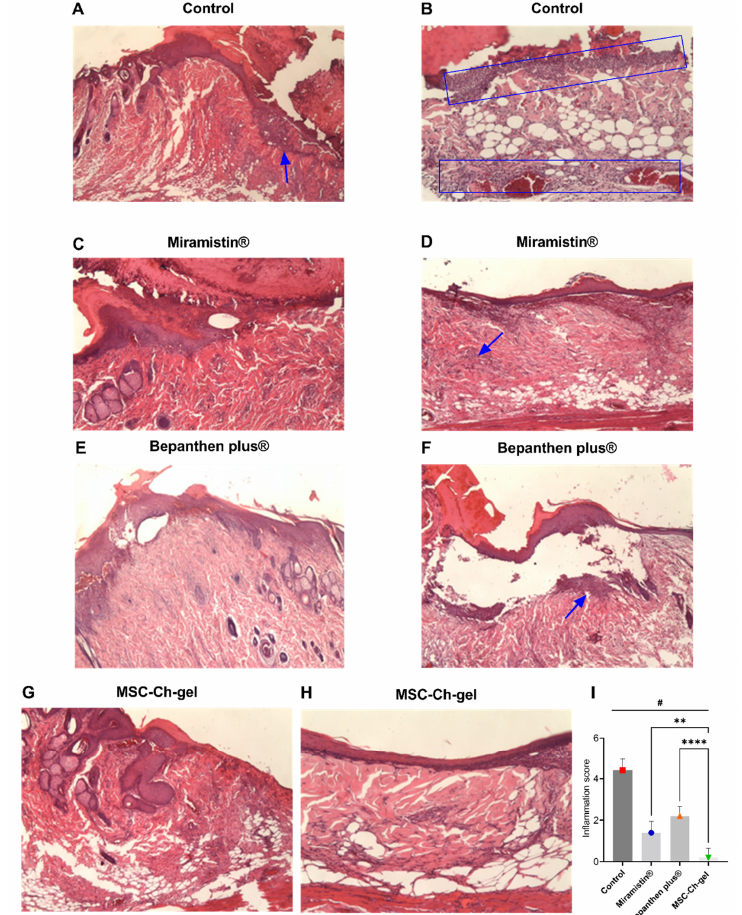
Figure 7. Histology of skin lesions on day 8 stained with haematoxylin and eosin and inflammatory infiltrate score on days 8. ( A , B ) Control (magnification, A ×25, B ×100). ( C , D ) Miramistin (magnification, ×40). ( E , F ) Bepanthen Plus (magni- fication, ×40). ( G , H ) MSC-Ch-gel (magnification, ×40, ×100). The blue rectangle and arrows indicate the area of the inflam- matory infiltrate. ( I ) Inflammation score. Plotted data are means ± standard deviation ( n = 5), # adjusted p < 0.001 for Control vs. Miramistin, Bepanthen Plus, and MSC-Ch-gel groups, ** adjusted p 0.0078 for Miramistin vs. MSC-Ch-gel, **** adjusted p < 0.001 for Bepanthen Plus vs. MSC-Ch-gel. All statistical analyses were performed using the one-way ANOVA. To compare groups vs Control (Dunnett’s post hoc test); to compare groups with each other (Tukey’s post hoc test). MMSC, multipotent mesenchymal stromal cell; MSC-Ch-gel, multipotent mesenchymal stromal cell secretome-based chi- tosan gel.